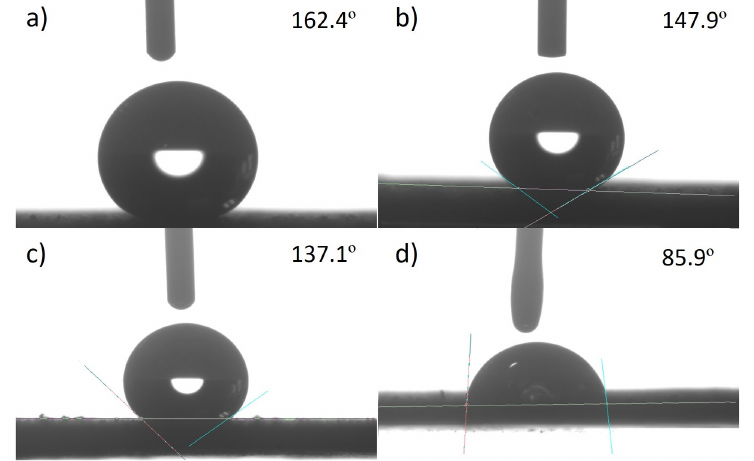
Figure 4. Water contact angle (WCA) for sample ( a ) C1 and ( b ) C5, and n-hexadecane contact angle for sample ( c ) C1 and ( d ) C5.